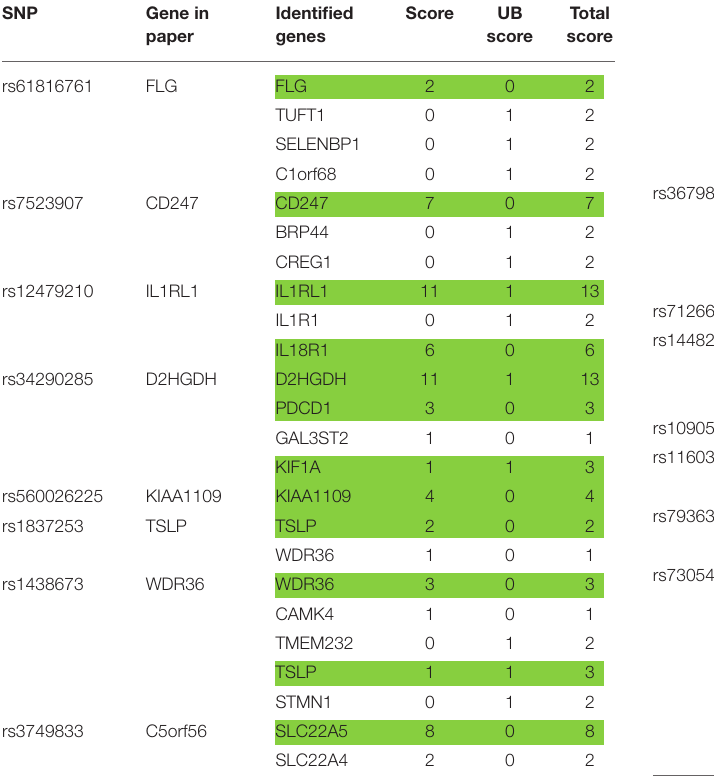
TABLE 4 | Selection of genes of interest relative to signal of